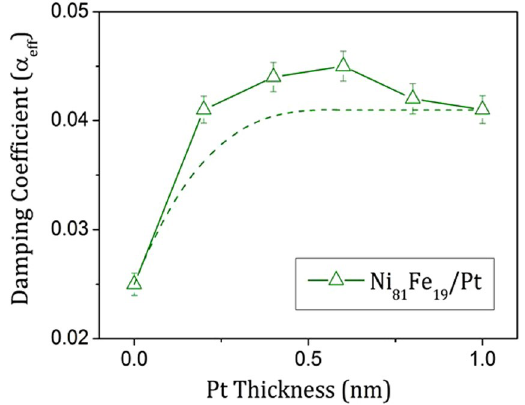
Figure 2. Effective damping coefficient obtained in NiFe/Pt thin films. The damping increases rapidly between 0 up to 0.6 nm Pt thickness, then above it goes down slowly. The dashed line illustrates the expected contribution to the damping from intrinsic